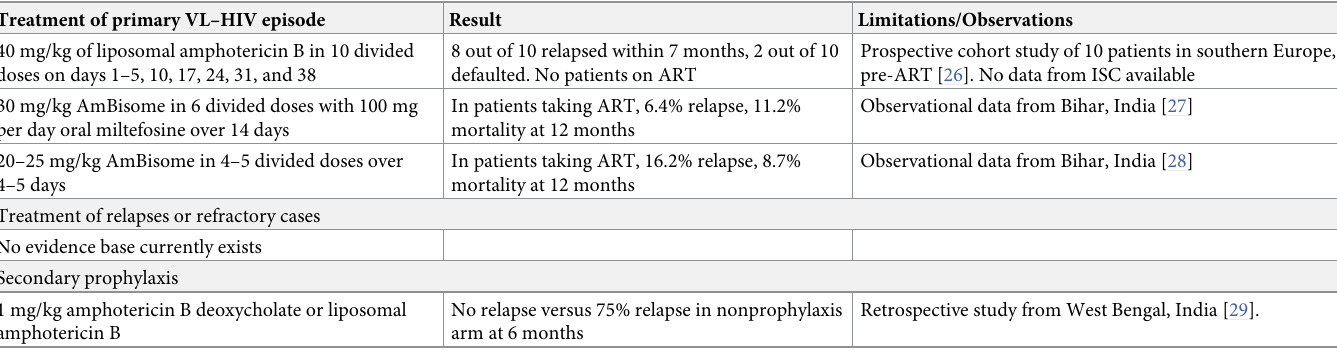
Table 2. Current evidence for treatment of VL–HIV coinfection in the ISC. Treatment of primary VL–HIV